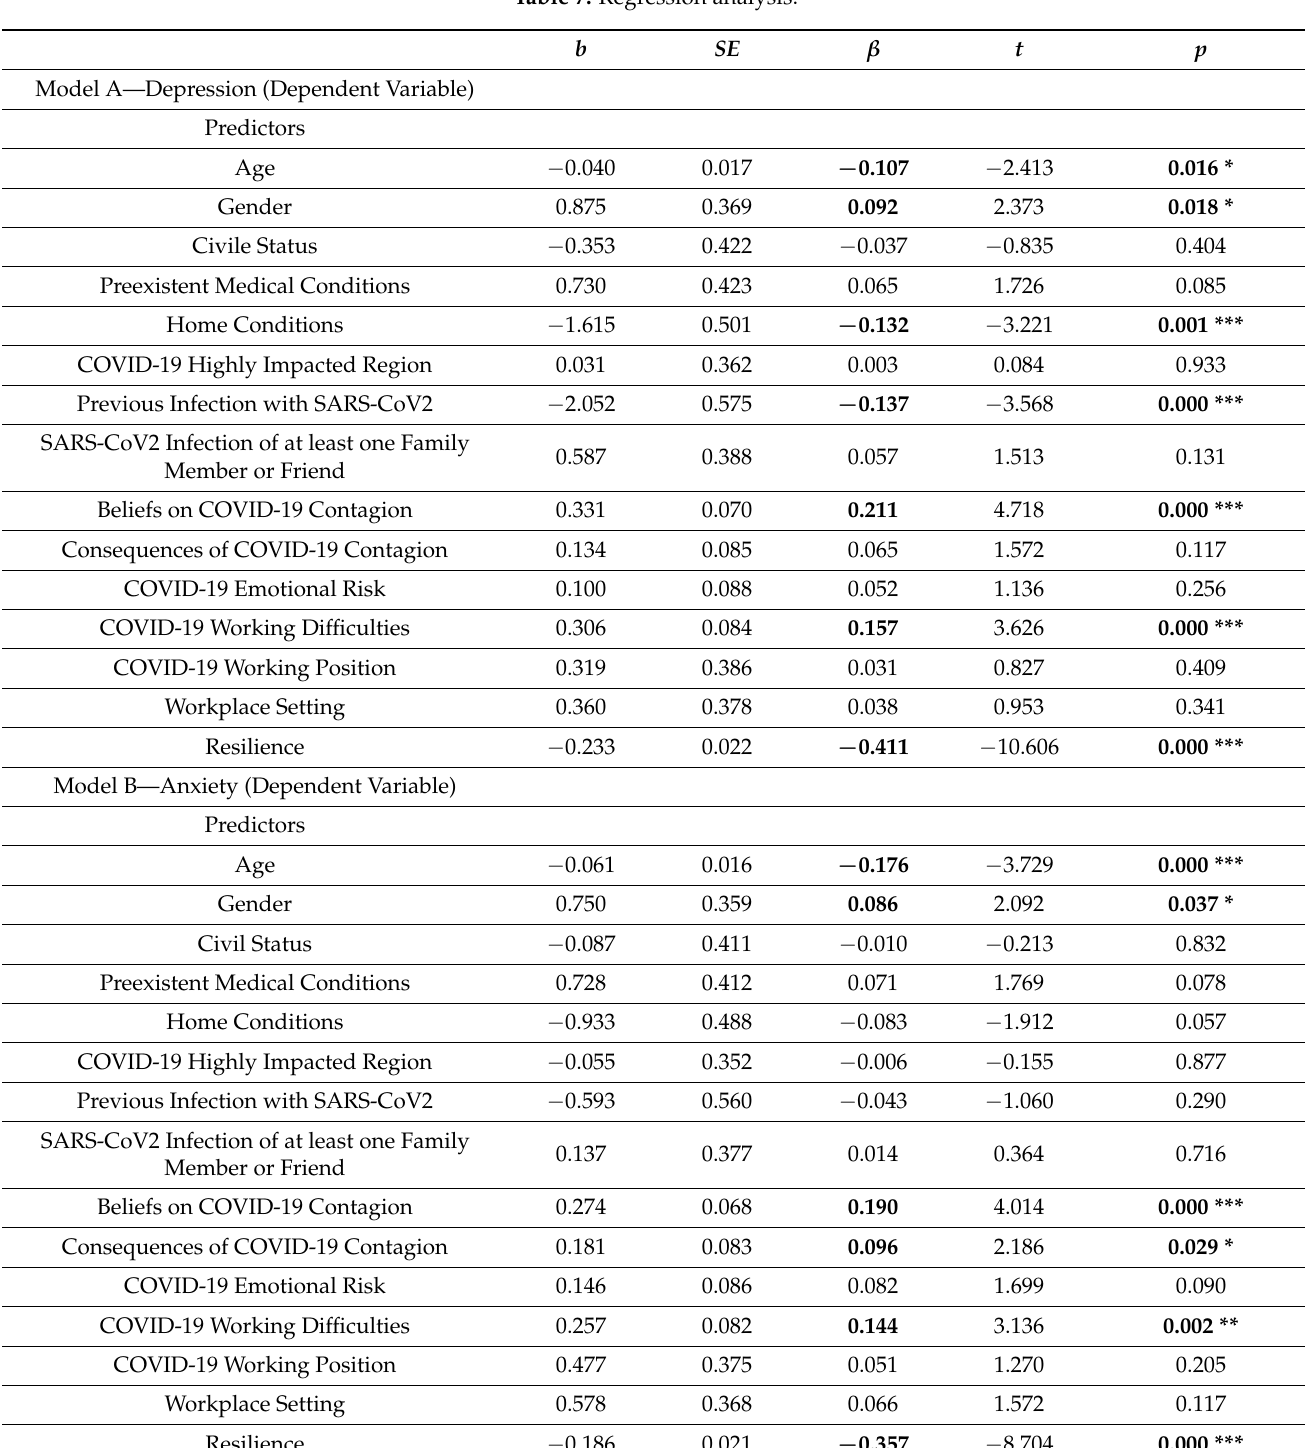
Table 7. Regression